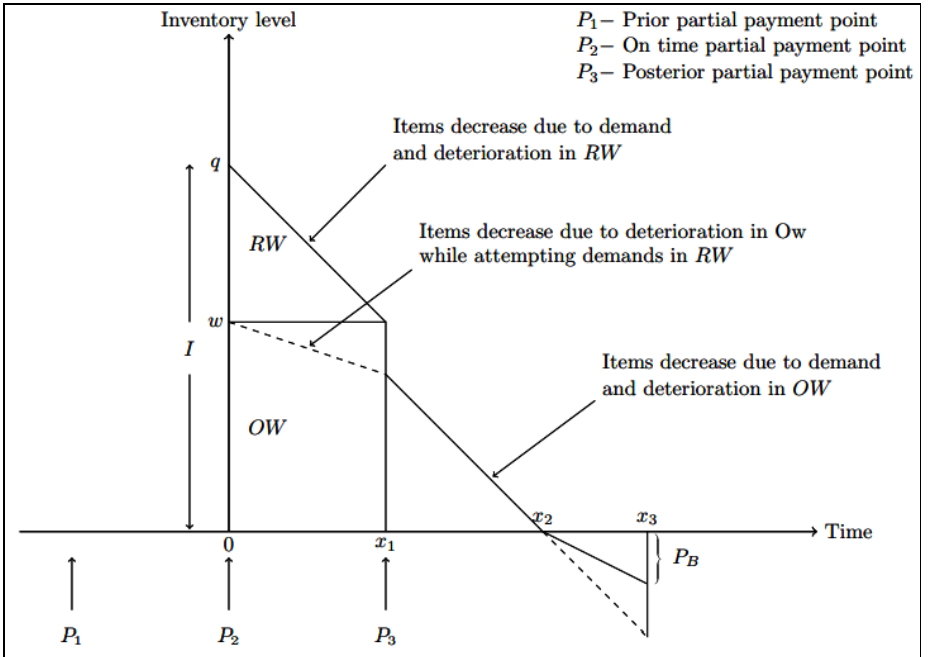
Figure 1. Diagrammatic representation of the model.